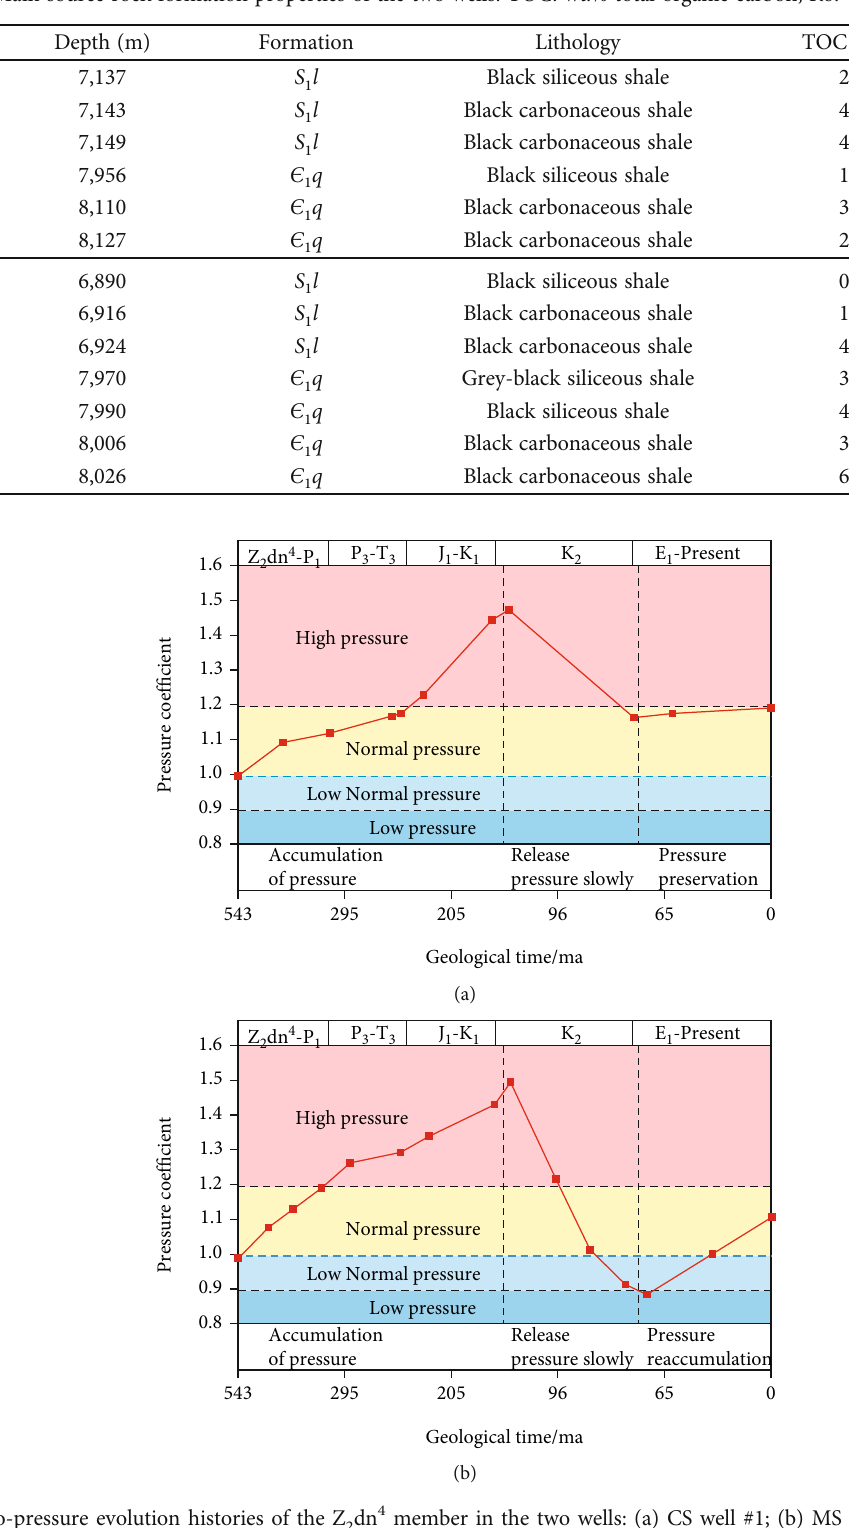
dn 4 member in the two wells: (a) CS well #1; (b) MS well #1, indicating a high- 2